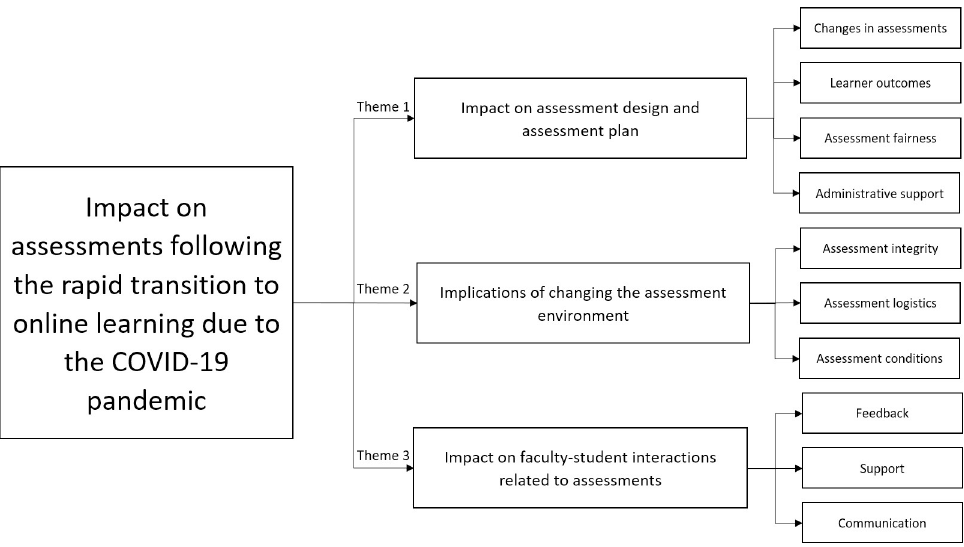
Fig 2. Themes and subthemes.